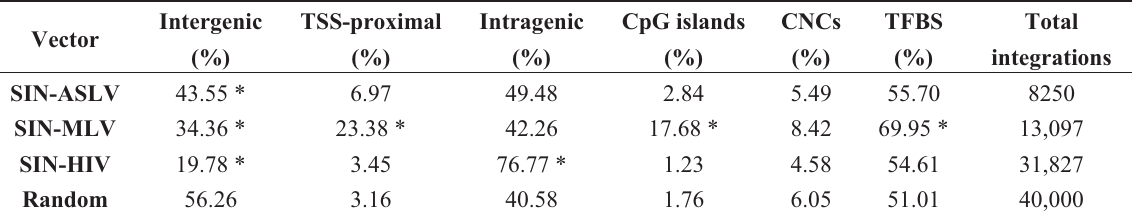
Table 1. Integration distribution around RefSeq genes and genomic features in the genome of human hematopoietic stem/progenitor cells (HSPCs). Intergenic TSS-proximal Intragenic CpG islands CNCs TFBS Total Vector (%) (%) (%) (%) (%) (%) integrations SIN-ASLV 43.55 * 6.97 49.48 2.84 5.49 55.70 8250 SIN-MLV 34.36 * 23.38 * 42.26 17.68 * 8.42 69.95 * 13,097 SIN-HIV 19.78 * 3.45 76.77 * 1.23 4.58 54.61 31,827 Random 56.26 3.16 40.58 1.76 6.05 51.01 40,000 Percentage of self-inactivating (SIN)-Moloney murine leukemia virus (MLV), SIN-avian sarcoma-leukosis alpha-retrovirus (ASLV) and SIN-HIV integrations and random sequences targeting intergenic, transcription start sites (TSS)-proximal and intragenic regions, regions annotated as CpG islands, conserved non-coding (CNC) regions and transcription factor binding sites (TFBS). For all the comparison with random sites,